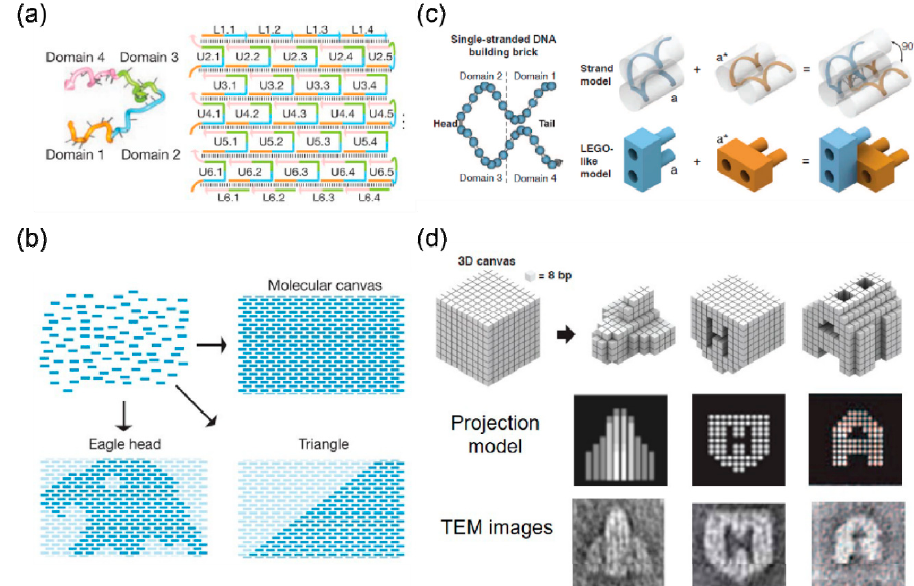
Figure 2. Single-stranded DNA tiles and single-stranded DNA bricks. ( a ) Rectangular 2D molecular canvas assembled by single-stranded DNA tiles. Reproduced from [42]. ( b ) Drawing the desired shape on the 2D molecular canvas. Reproduced from [42]. ( c ) LEGO model analogue of single-stranded DNA. Reproduced from [7]. ( d ) “Carving” the 3D canvas into any shape. Reproduced from [7].